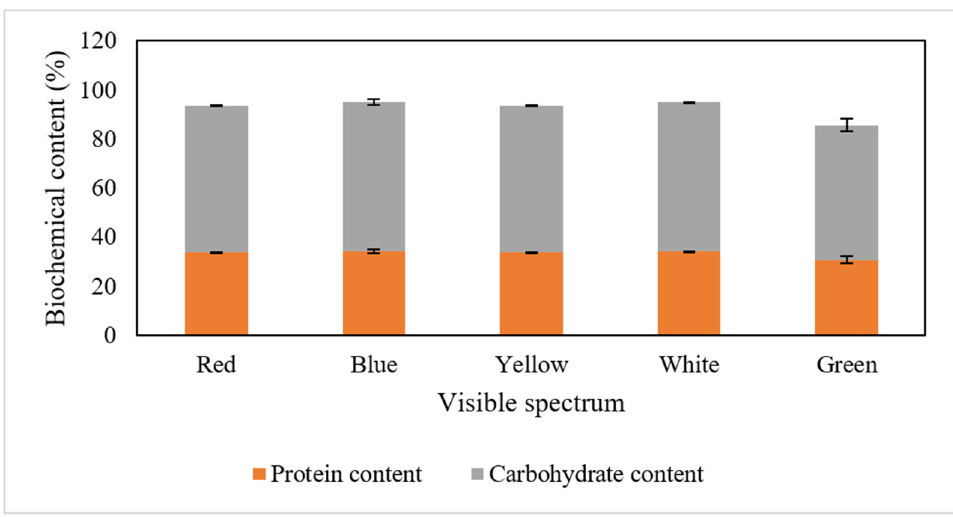
Figure 3. Protein and carbohydrate content of attached microalgae growing on palm decanter cake at various visible spectra of irradiation.